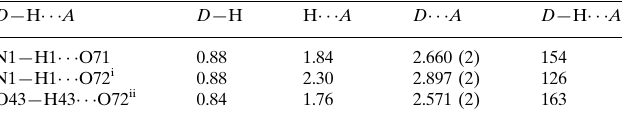
Hydrogen-bond geometry (A˚ , (cid:3)